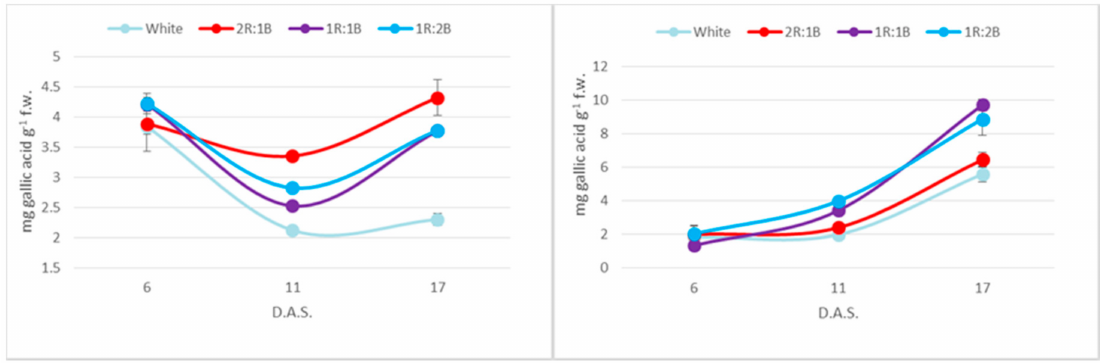
Figure 4. Total phenolic contents of: green basil cultivar ( Left ); and red basil cultivar ( Right ).